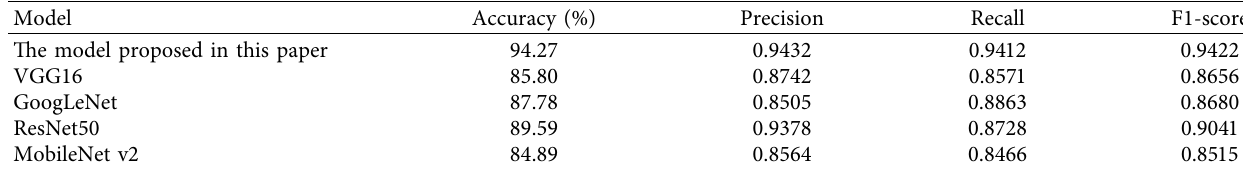
Table 4: Classification results of different models for Lentinus edodes stick